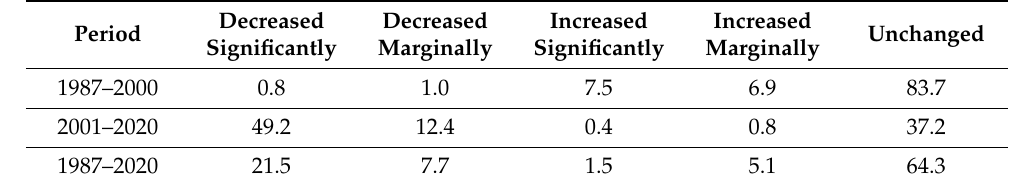
Table 2. Area percentage of different vegetation change trends (%).